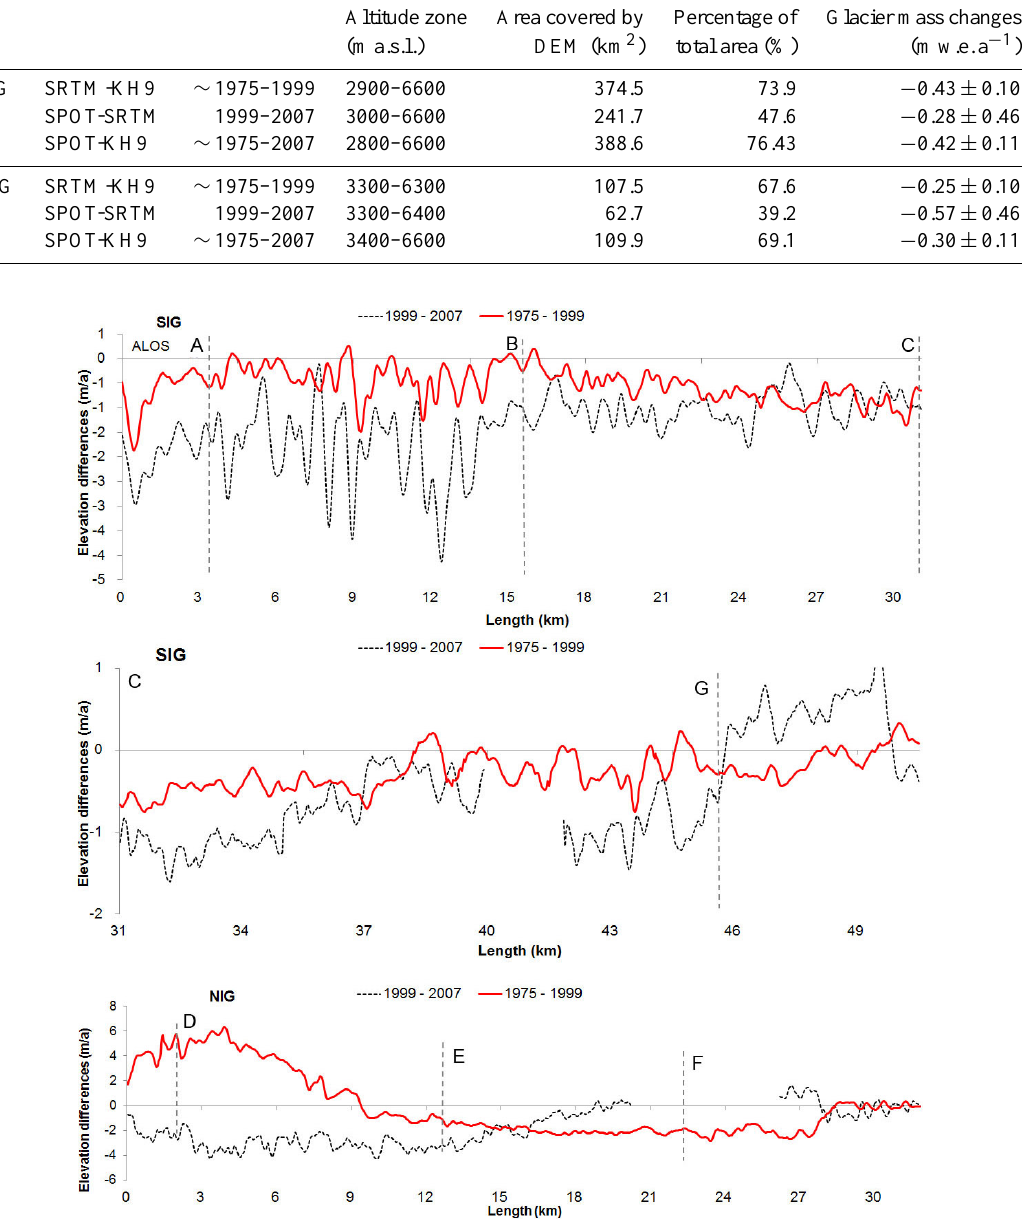
Figure 5. Longitudinal profiles of SIG and NIG for the periods ∼ 1975–1999 (KH-9–SRTM) and 1999–2007 (SRTM–SPOT). The section of ALOS PRISM between the tongue of SIG and point A was derived from SRTM–ALOS in black